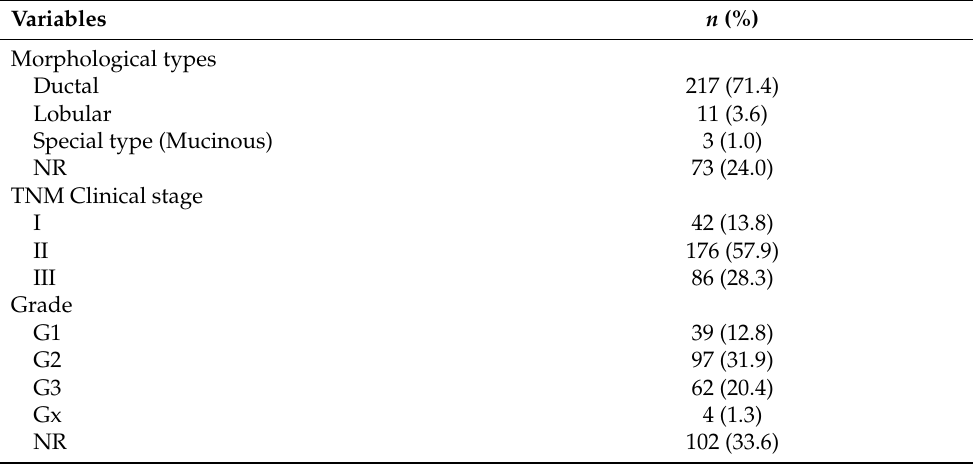
Table 2. Tumor characteristics of breast cancer women undergoing CT ( n = 304), Brazil,